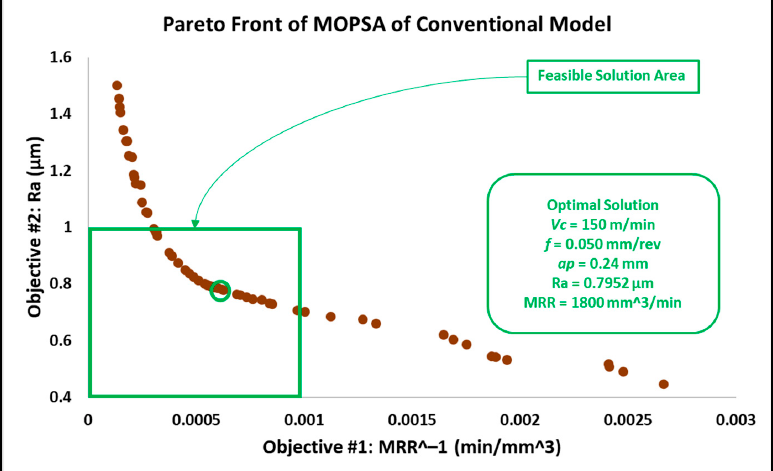
Figure 12. Pareto front plot of MOPSA solution of the conventional model.